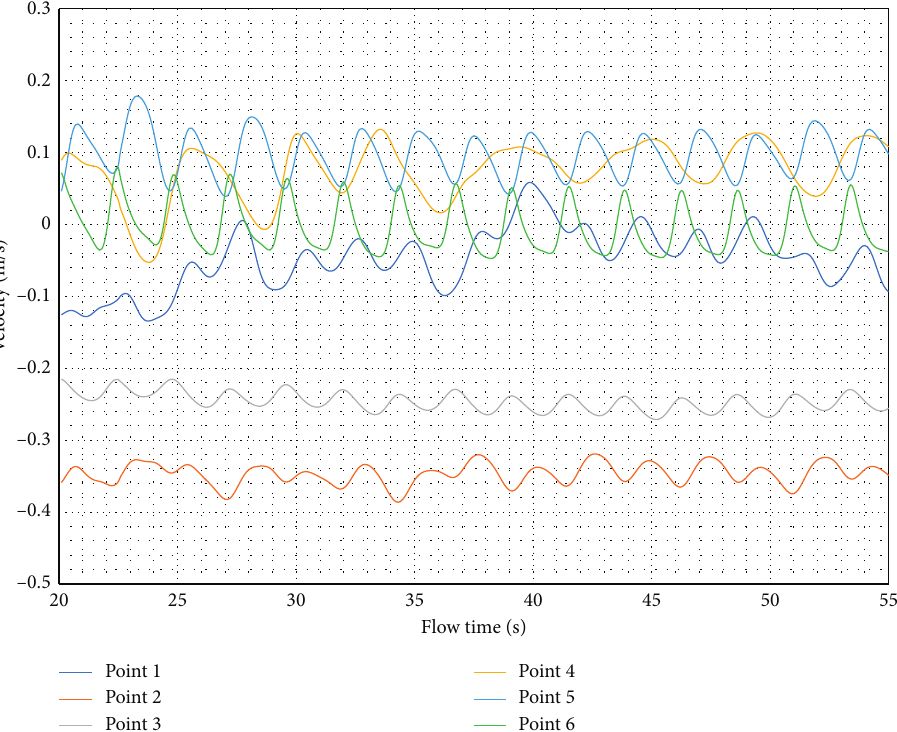
Figure 11: Velocity in the function of time along the z -direction V